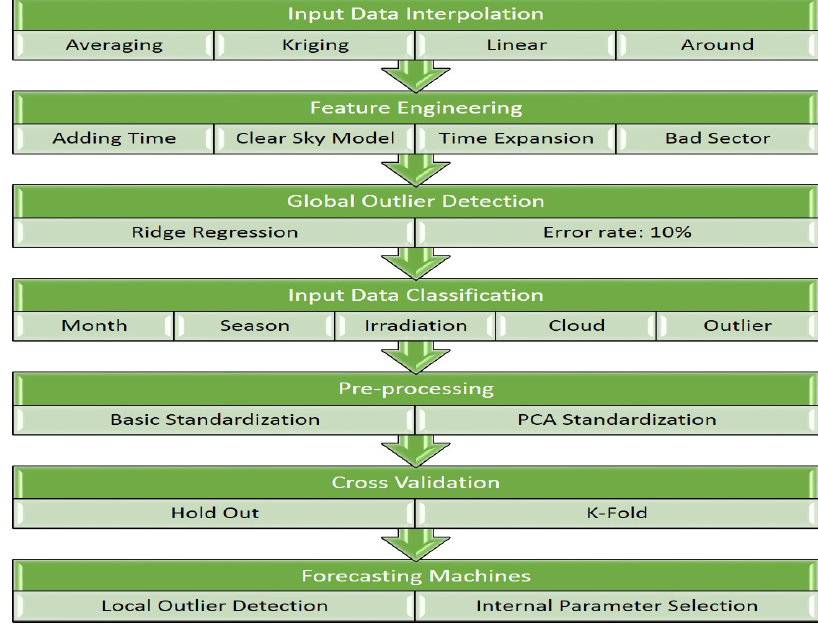
Figure 3. The overall forecasting process is described. The cross validation shown in this figure is used to determine the optimal internal parameters in the forecasting